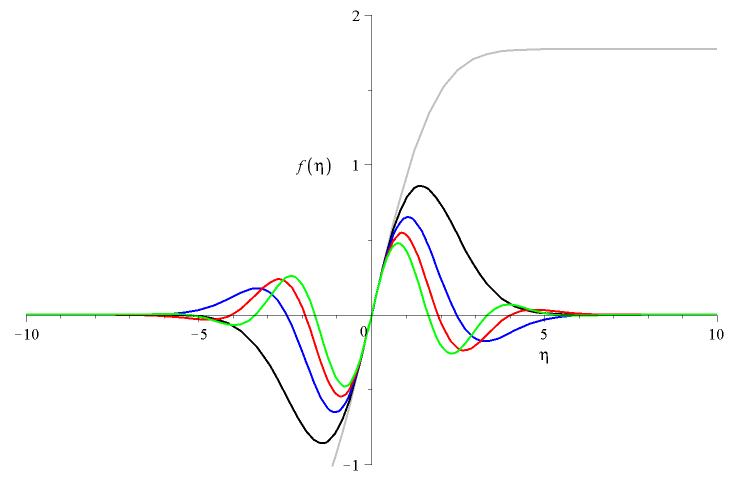
Figure 1. Five evaluated shape functions f ( η ) in Equation (9). The gray, black, blue, red and green curves are for α = 0,1,2,3 and 4, respectively. Additional parameters κ 1 and D are set to unity.